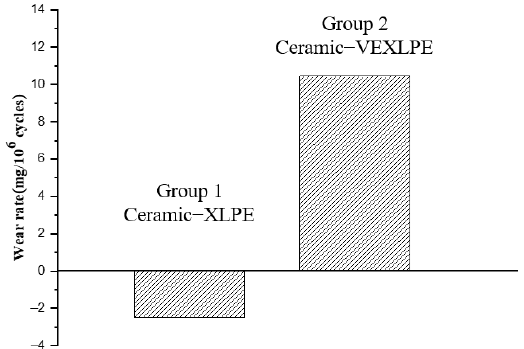
Figure 3. Wear rate for Group 1 and Group 2.